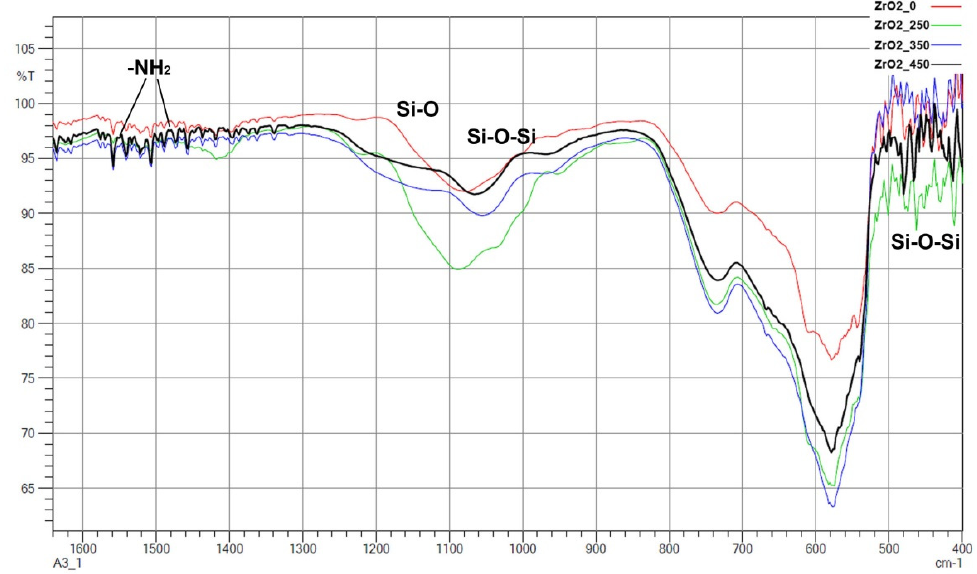
Figure 9. FTIR spectra of all APTES modfied zirconia samples.